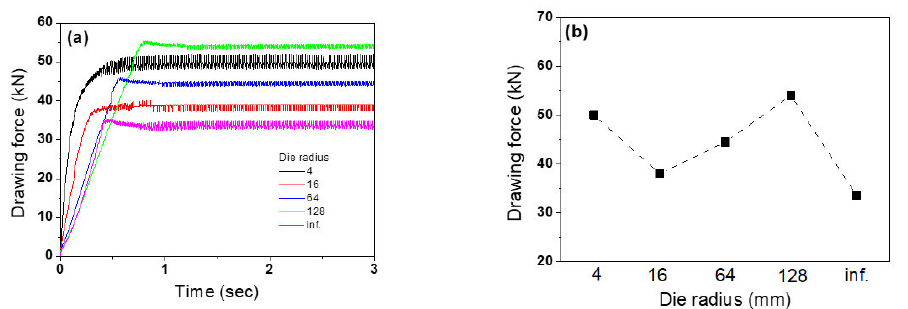
Figure 11. Comparison of ( a ) history of drawing force along the drawing direction and ( b ) the steady-state drawing force with the die radius.